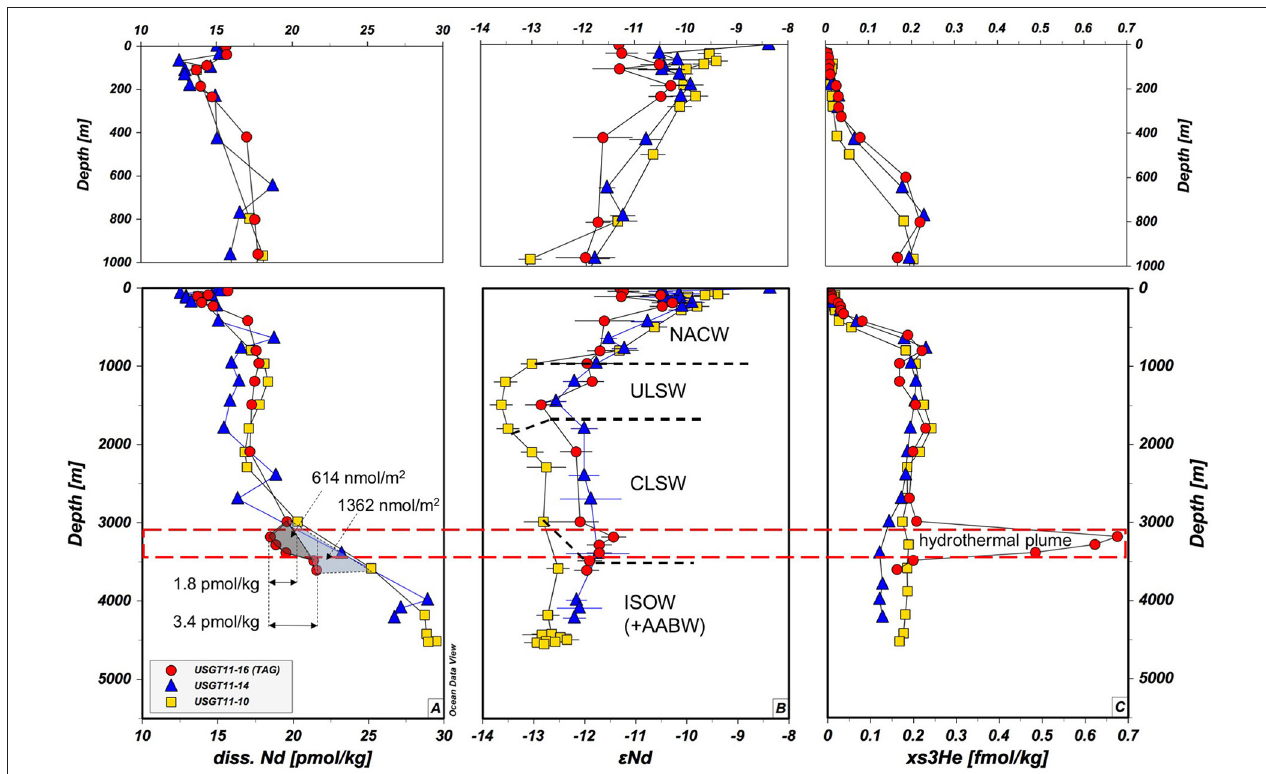
FIGURE 2 | Vertical distribution of dissolved Nd concentration (A) , Nd isotopic composition (B) and (C) mantle derived excess He (xs 3 He, Jenkins et al., 2015a). Color coding the same as in Figure 1 . The dashed red line shows the vertical position of the neutrally buoyant hydrothermal plume in the water column. The figure is designed with ODV ® software ( Schlitzer,